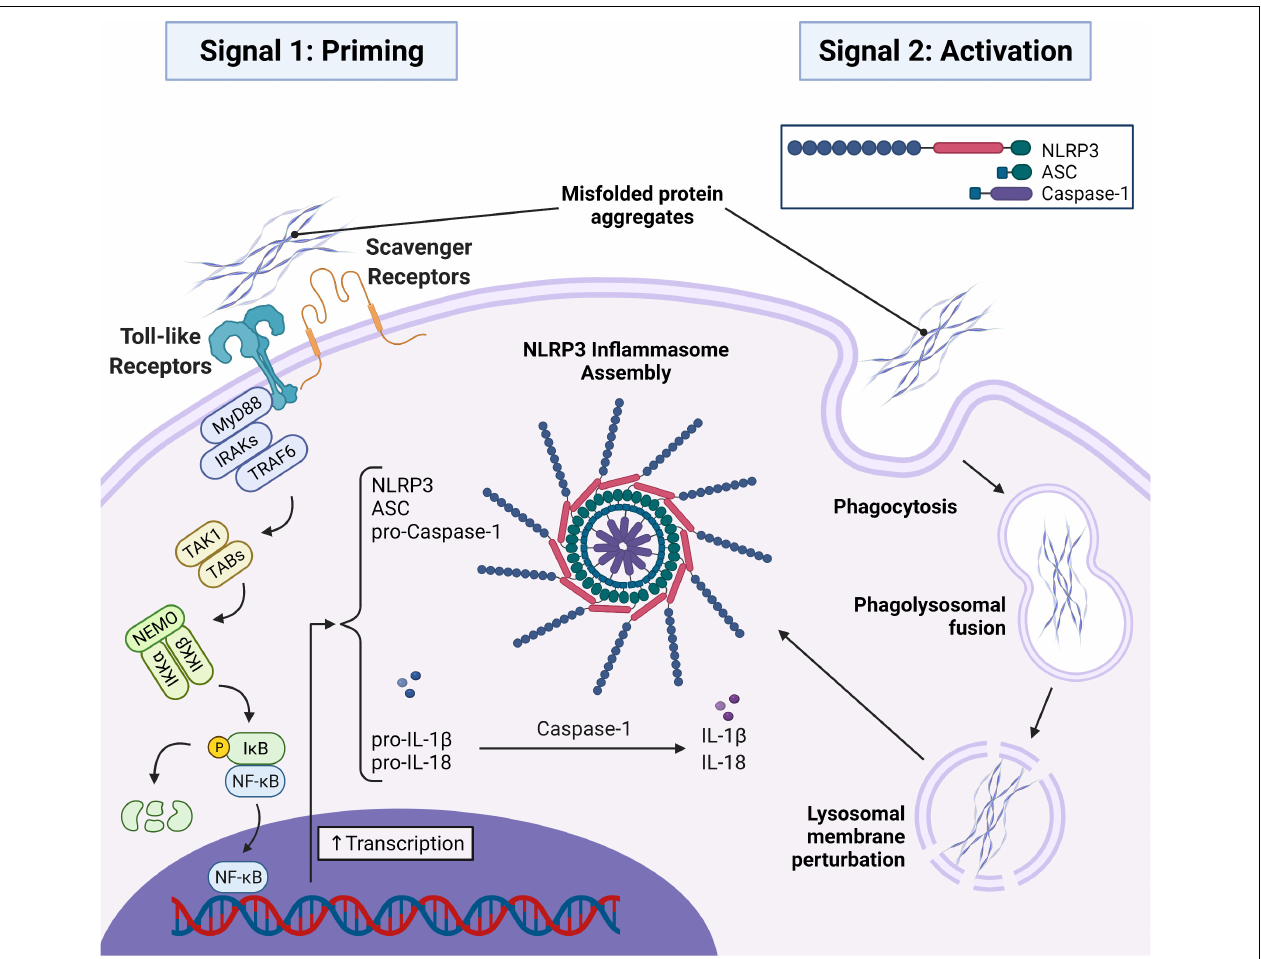
FIGURE 1 | AD and PD related misfolded protein aggregates (A β , tau, and α -syn) initiate signal 1 and signal 2 required for assembly of the NLRP3 inflammasome and subsequent ASC speck. In signal 1, misfolded protein aggregates bind to toll-like and scavenger receptors on the microglial cell surface initiating a MyD88-dependent signaling transduction event resulting in the translocation of NF- κ B into the nucleus to initiate the transcription of important inflammasome components and the immature forms of the inflammatory cytokines pro-IL-1 β and pro-IL-18. In signal 2, misfolded protein aggregates are taken into the cell via phagocytosis and trafficked to the lysosome where they disrupt the lysosomal membrane and trigger assembly of the inflammasome. Oligomerization of NLRP3 then recruits ASC which oligomerizes with NLRP3 via homotypic interactions between PYD regions of both proteins. Pro-caspase-1 is then recruited to the oligomerized ASC via homotypic interactions between CARD regions. Dimerization of pro-caspase-1 triggers an autolytic cleavage event producing two active caspase-1 enzymes that can mature pro-IL-1 β and pro-IL-18 into the mature IL-1 β and IL-18. MyD88, myeloid differentiation primary response gene 88; IRAK, IL-1 receptor-associated kinase; TRAF6, TNF receptor associated factor 6; TAK1, transforming growth factor- β -activated kinase-1; TAB, TAK1 binding proteins; NEMO, NF- κ B essential modulator; IKK α / β , Inhibitor of NF- κ B Kinase; I κ B, Inhibitor of NF- κ B; NF- κ B, nuclear factor-kappaB; IL-1 β /18, interleukin-1 β